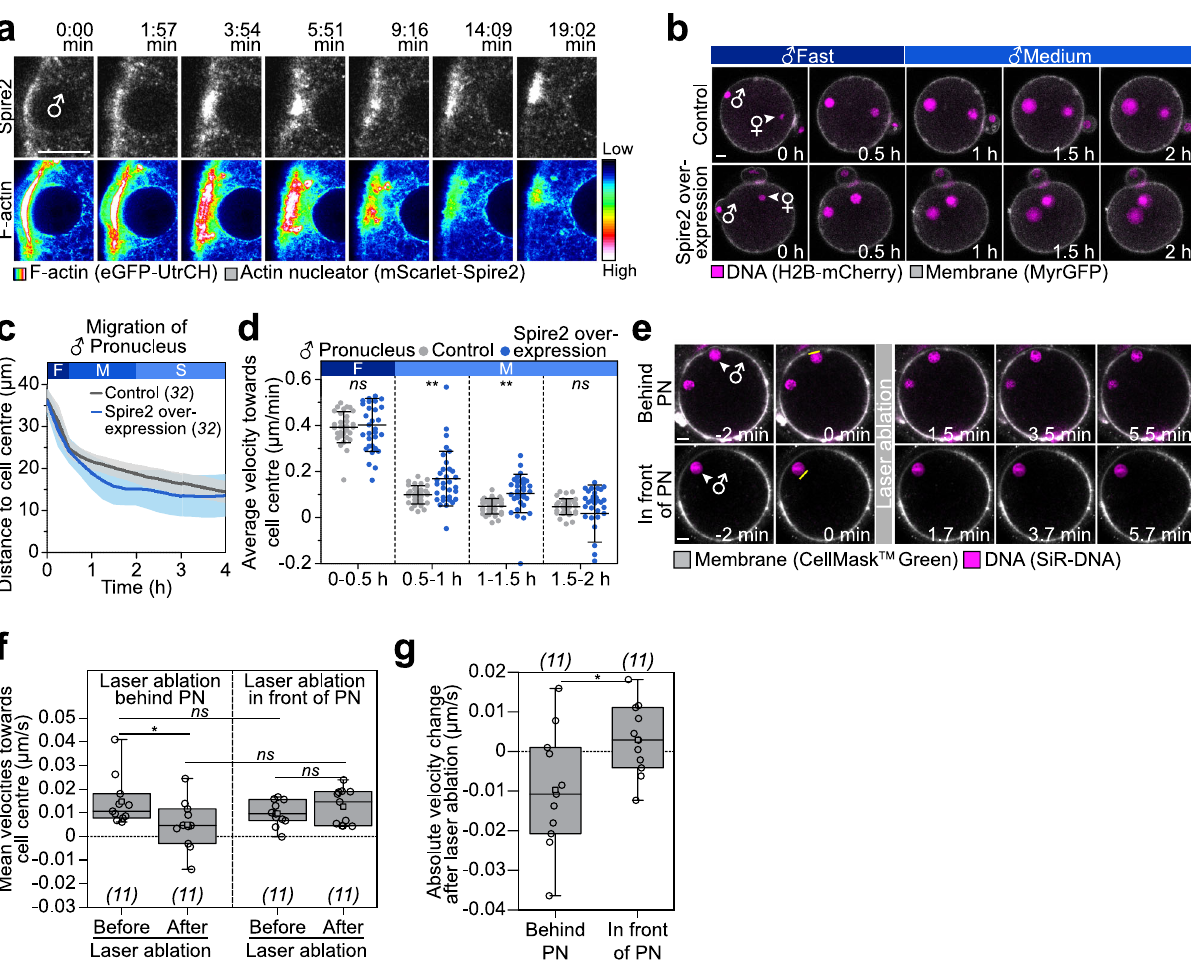
Fig. 5 Spire-dependent local actin nucleation drives pronuclear migration in the periphery of the zygote. a Super-resolution (airyscan) time-lapse images of mScarlet-Spire2 (white) and F-actin (EGFP-UtrCH, pseudocolour, 12-Bit grayscale) in live zygotes in proximity of the forming male pronucleus displayed as single plane. Time point 0 marks the start of acquisition. Corresponding look-up table is shown as a colour scale ranging from intensity levels 1 (low) to 4096 (high). b Three-dimensional time-lapse images of pronuclei and the cell surface relative to pronuclear formation (0 h) in zygotes overexpressing SNAP (control) or SNAP-Spire2. Female ( ♀ ) and male ( ♂ ) genomes are shown. Phases with respective movement speeds are classi fi ed as in Fig. 1a. c The mean distance (thick line) of male pronuclei centroids to zygote centre during pronuclear migration in zygotes overexpressing SNAP or SNAP-Spire2 was calculated from ( b ). The total number of analyzed zygotes speci fi ed in italics was pooled from three independent experiments. S.d. shown as shaded areas. d Statistical plots of average velocities of male pronuclei during pronuclear migration in zygotes overexpressing SNAP (control) or SNAP-Spire2 calculated from ( c ) with the same sample size as in ( c ). Statistical plot shows mean ± s.d. Two-tailed Student ’ s t test was used to test for signi fi cance (from left to right: p = 0.7, p = 0.003, p = 0.001 and p = 0.2). e Laser ablation of live zygotes behind or in front of the male pronucleus (PN) during fast migration phase; yellow boxes indicate region of laser ablation. Single section time-lapse images of pronuclei (SiR-DNA) and the cell surface (CellMask Green) in live zygotes relative to time point of laser ablation (0 min) are presented. Images were acquired at 20-s intervals before and after laser ablation. f Box plot of velocities showing median (line), mean (small square), 5th, 95th (whiskers) and 25th and 75th percentile (box) with individual values (circles) calculated from Supplementary Fig. 5f as an average velocity of the 80 s time window before and after ablation from the total number of zygotes (italics) pooled from four independent experiments. Migration towards cell centre (>0) and towards cell surface (<0). Two-tailed Student ’ s t test was used to test for signi fi cance (from top to bottom: p = 0.2, p = 0.04, p = 0.06 and p = 0.3). g Box plot of velocity change after laser ablation showing median (line), mean (small square), 5th, 95th (whiskers) and 25th and 75th percentile (box) with individual values (circles) calculated from ( f ) with the same sample size as ( f ). Absolute velocities were calculated through subtraction of velocities before ablation from velocities after ablation. Increase (>0) or decrease (<0) of velocity after laser ablation. Two-tailed Student ’ s t test was used to test for signi fi cance ( p =